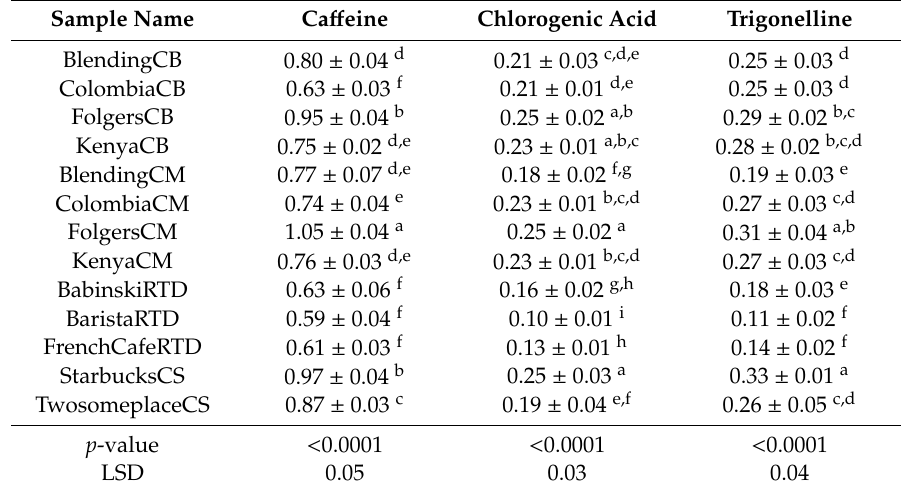
Table 3. Mean amount of ca ff eine, chlorogenic acid, and trigonelline of CB co ff ee samples (mg / mL) 1,2,3